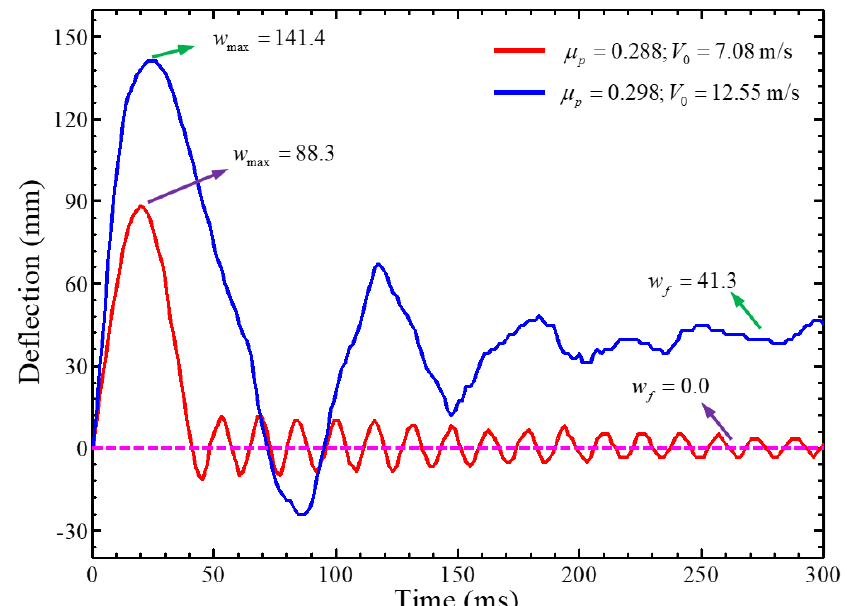
Figure 8. The record of deflection on the mid − span of strands with the same pre − stress but different input energy under the loading cases of